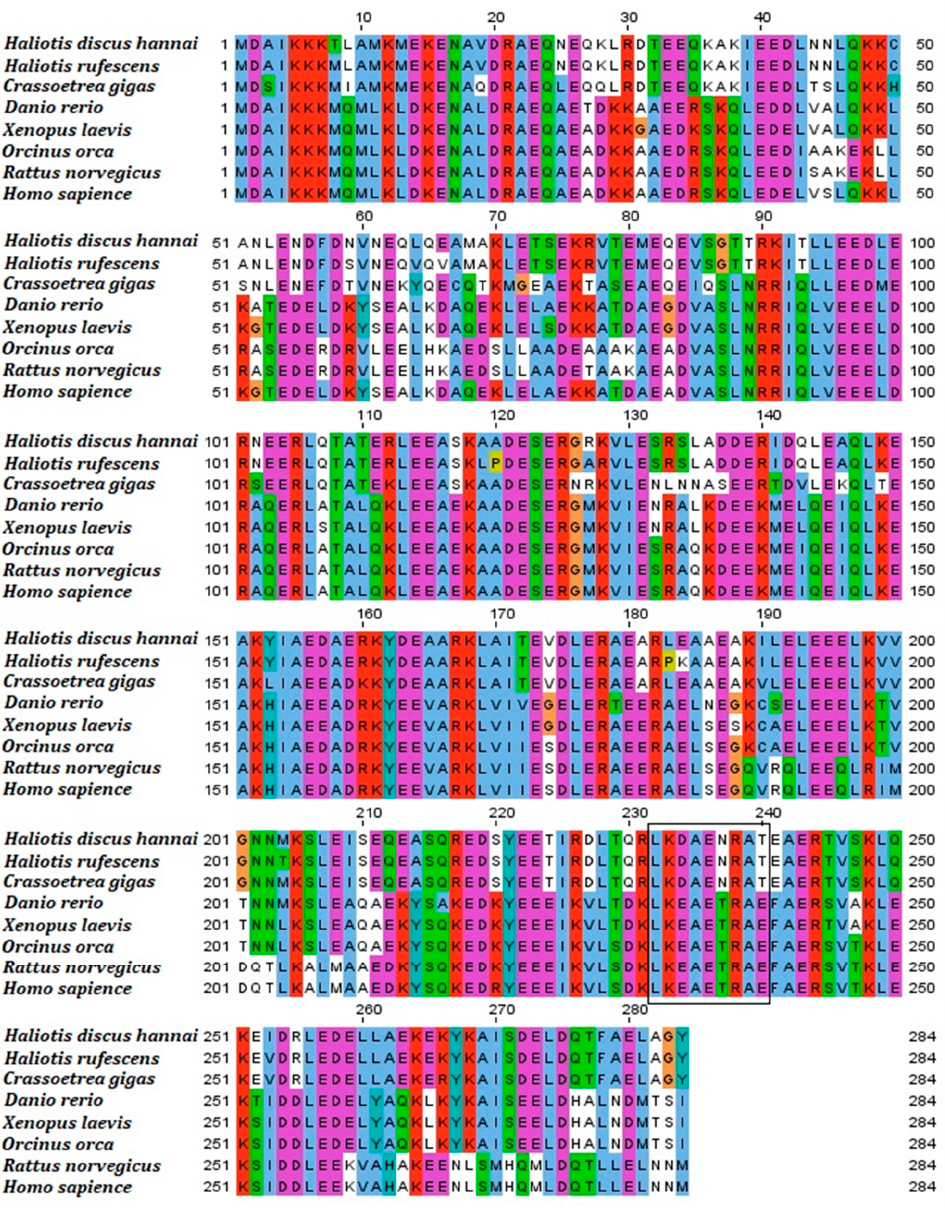
Figure 3. The multiple sequence alignment of Hdh-TPM from deduced amino acid sequences of H. discus hannai (OM937906), H. rufescens (X75218.1), H. discus discus (AB444939.1), Crassostrea gigus (AB444943.1), Mizuhopecten yessoensis (AB004636.1), Scylla serrata (EF672351.1), Pennahia argentata (AB045645.2), Mus musculus (AAI32038.1), Gallus gallus (AAA49112.1), and Homo sapiens (AAA36771.1). Tropomyosin signature is indicated by a black outlined